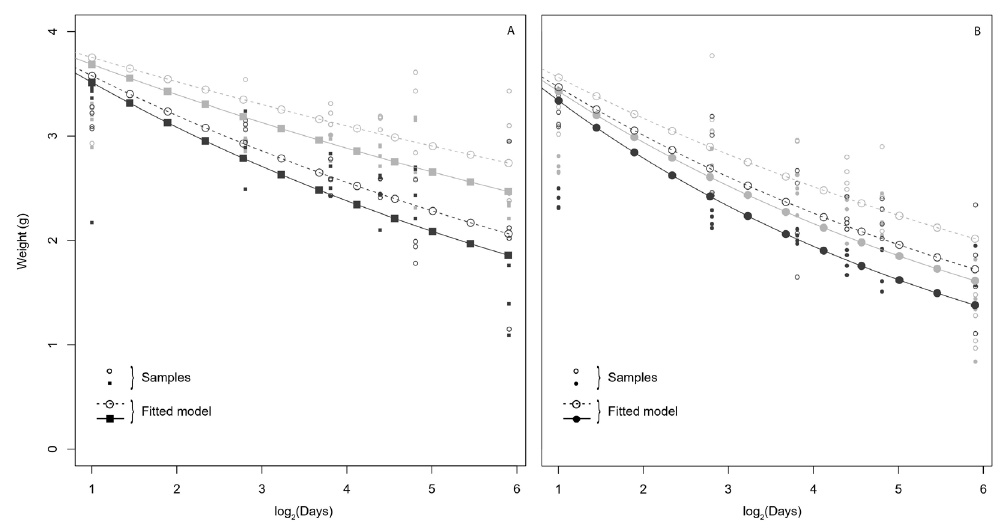
Figure 2. Final models fitted to the observed data. In both cases, time of the year and species influenced the decomposition rates. Panel A: first experiment, involving E. grandis vs. L. molleoides ). Panel B: second experiment ( E. grandis vs. M. aquifolium ). In light gray: dry season; in dark gray: rainy season. Dashed lines: E. grandis (open circles in A and B); continuous lines: L. molleoides (squares in A) and M. aquifolium (closed circles in